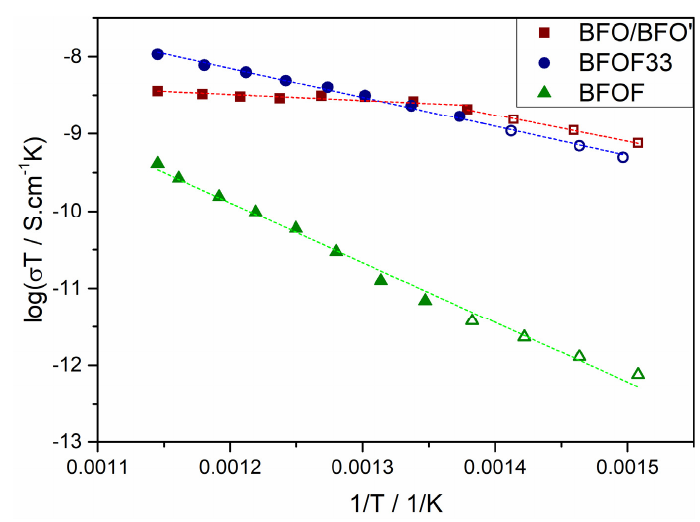
Figure 16. Arrhenius plot for the conductivity of BFO / BFO’ ( (cid:4) ), BFOF33 ( • ) and BFOF ( (cid:78) ). Dashed lines represent the performed fit for the activation energy. Table 2. Activation energies as calculated from the Arrhenius plots in Figure 14.